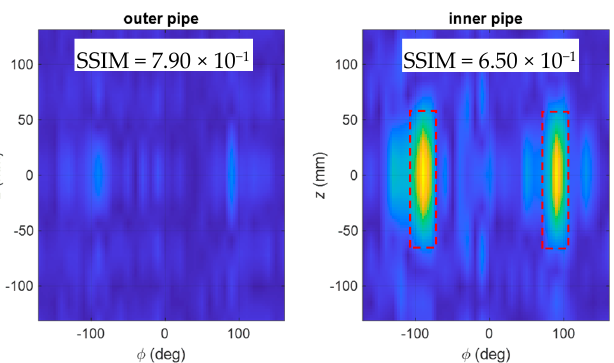
Figure 9. Reconstructed 2D images for two defects on the inner pipe. The red, dashed lines show the locations of the defects.